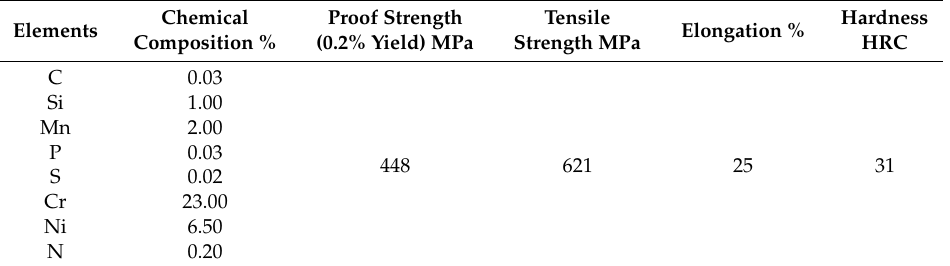
Table 2. Chemical composition and mechanical properties of AISI 2205